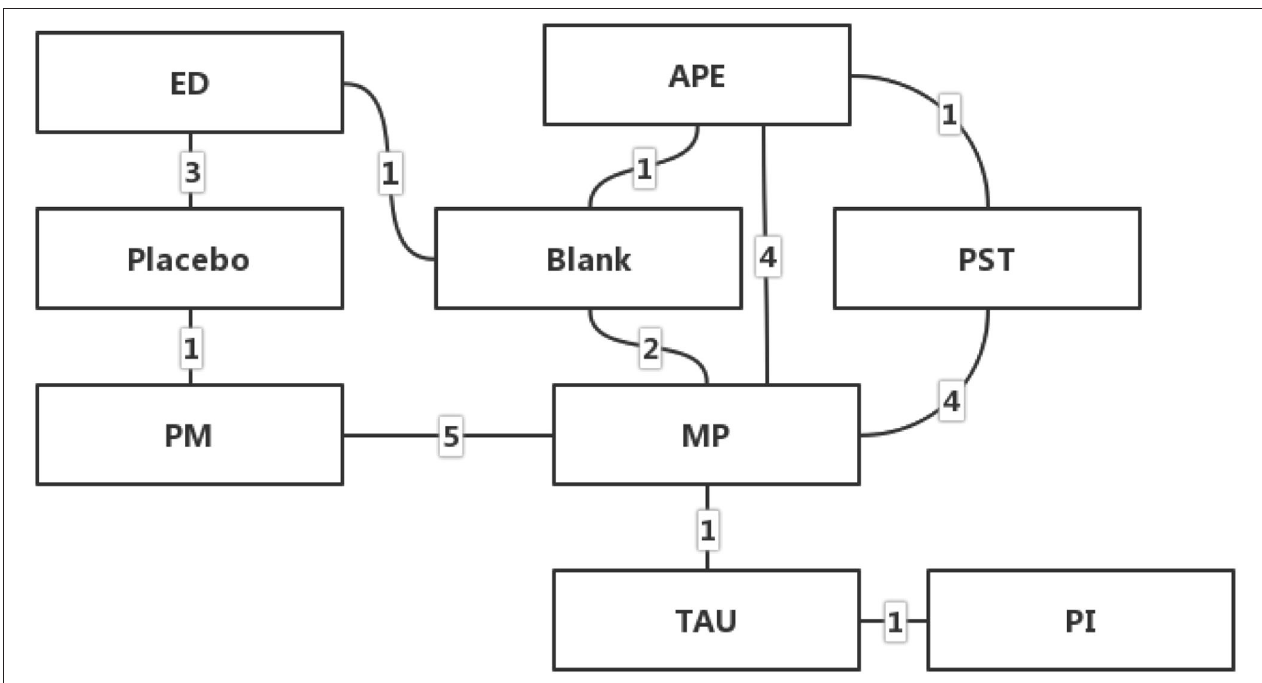
FIGURE 3 | Network geometry of the interventions (APE, Active Physical Exercise; ST, Supervised Training; PI, Psychological Intervention; MP, Multi-modal Protocols; PM, Passive Modalities; ED, External-used Devices; TAU, Treatment as Usual; These figures represent the number of studies that have made direct comparisons between